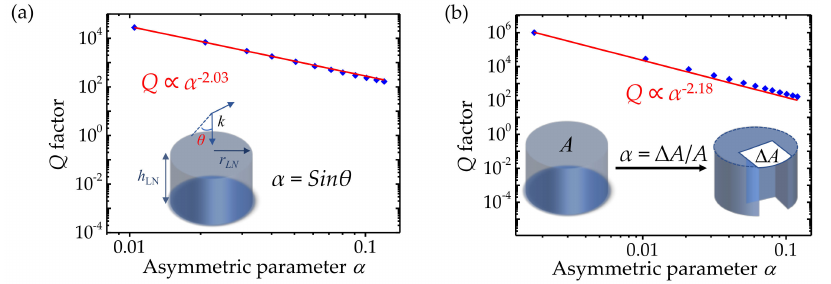
Figure 4. Simulated Q factor on the asymmetry parameter α for different design (log-log scale). Bottom Inset: the definition of the asymmetry parameter α . ( a ) Symmetric cylinder with oblique incidence. ( b ) Asymmetric cylinder with normal